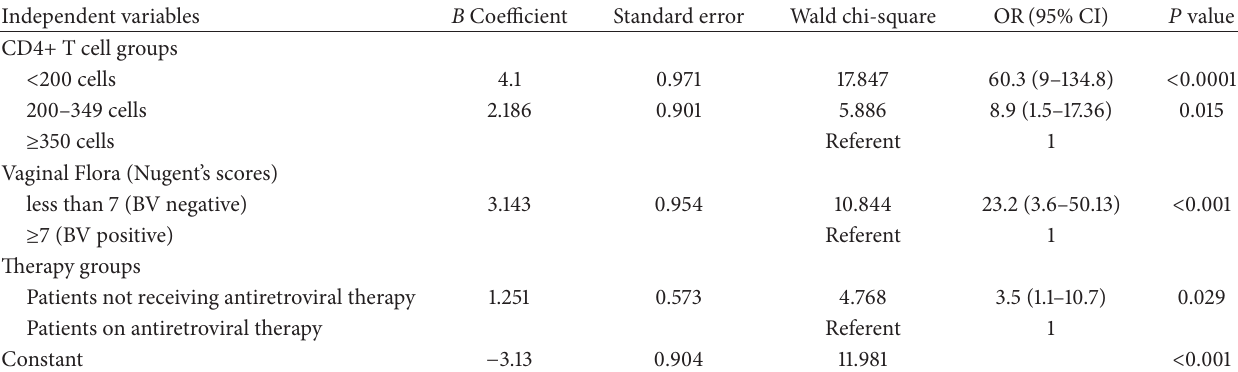
Table 3: Determinants of symptomatic vulvovaginal candidiasis among HIV-infected